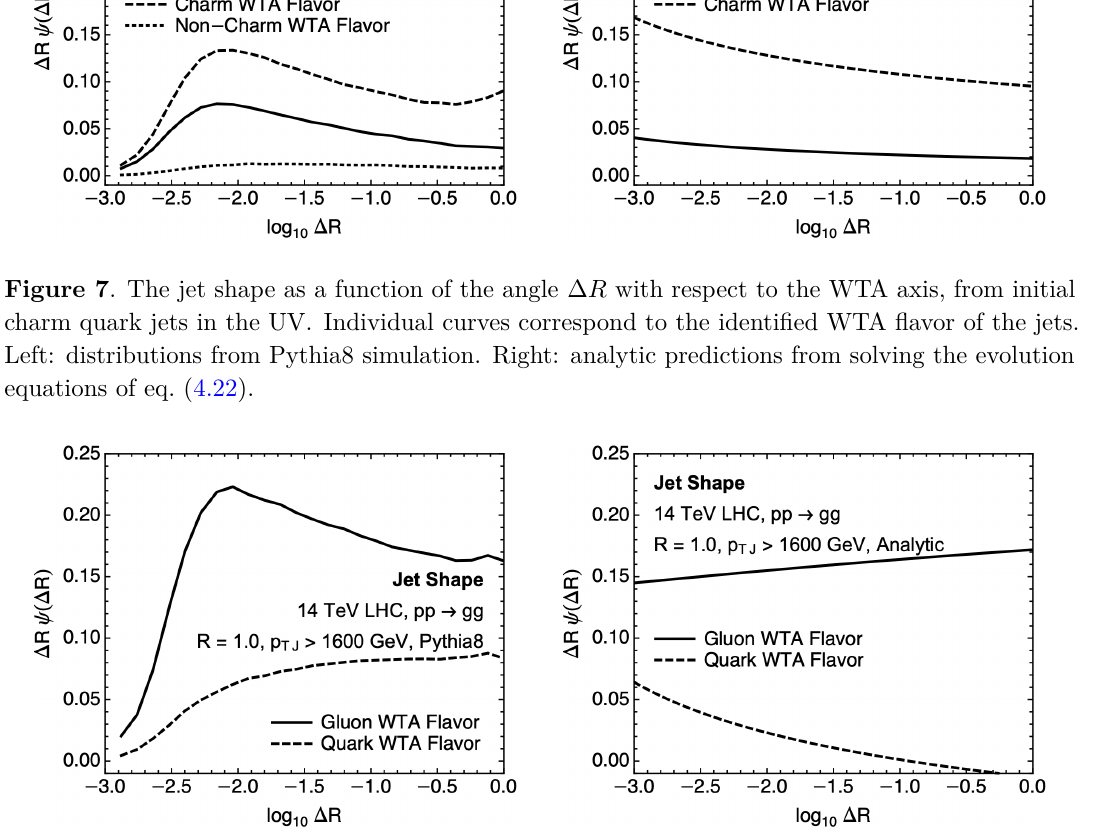
Figure 8 . The jet shape as a function of the angle ∆ R with respect to the WTA axis, from initial gluon jets in the UV. Individual curves correspond to the identified WTA flavor of the jets. Left: distributions from Pythia8 simulation. Right: analytic predictions from solving the evolution equations of eq.